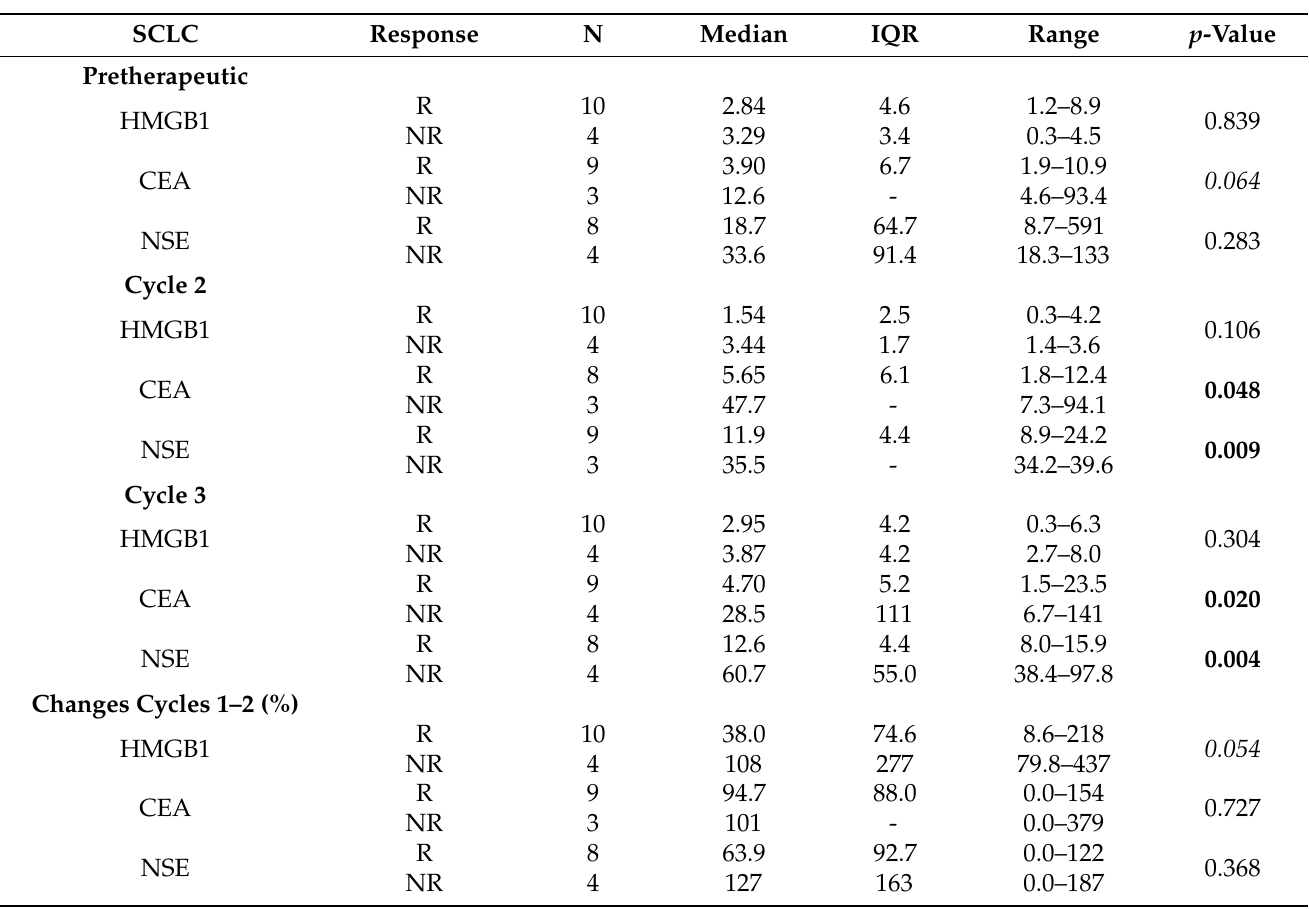
Table 3. Prediction of therapy response in SCLC by